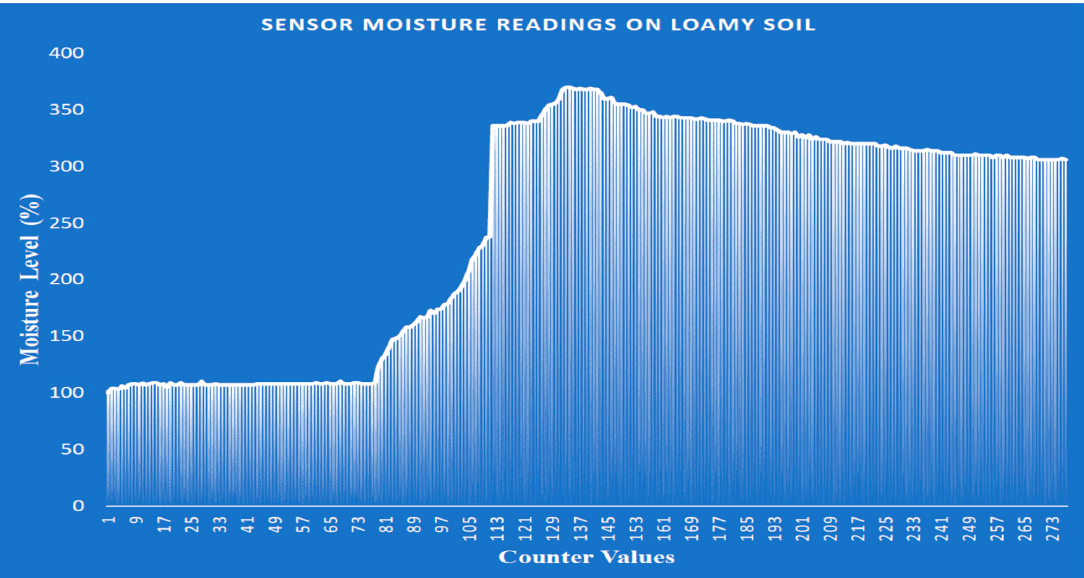
Figure 20. Soil moisture level against counter values on loamy soil.